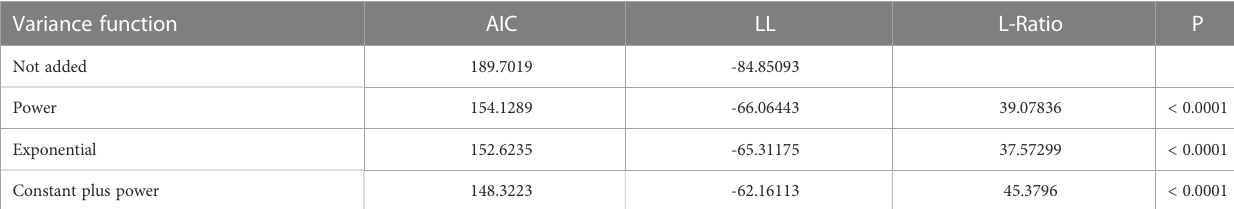
TABLE 5 Comparison among three variance functions (Eqs. 13 – 15) of NLME CW model (LL, logliklihood; AIC, Akaike Information Criterion; and L- Ratio, log-likelihood ratio test). Variance